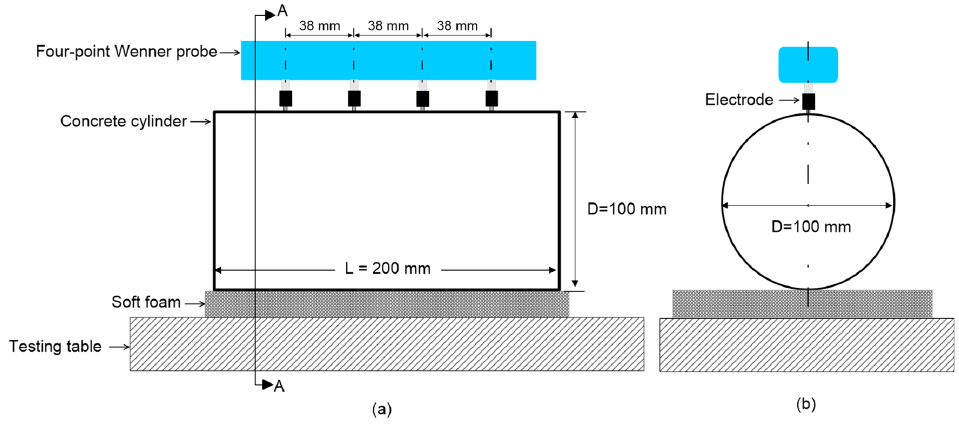
Figure 4. Test setup of electrical resistivity measurements of concrete: ( a ) four-point Wenner probe configuration, with an equal distance (=38 mm) between the electrodes, and ( b ) A-A section view of the Wenner probe configuration in Figure 4a.